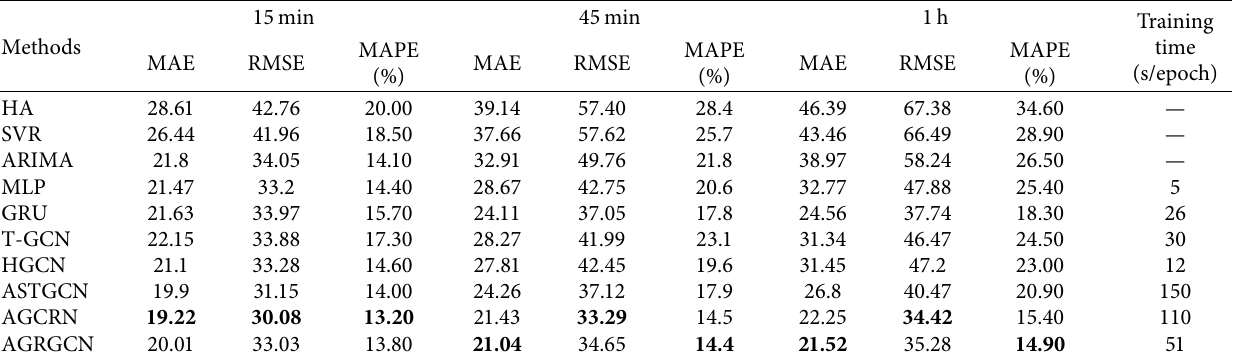
Figure 6: Comparison between the real trafc fow and the predicted values for some randomly selected nodes on two diferent time- granularity datasets. Table 2: Te prediction performance of diferent model on the PeMSD4 dataset.